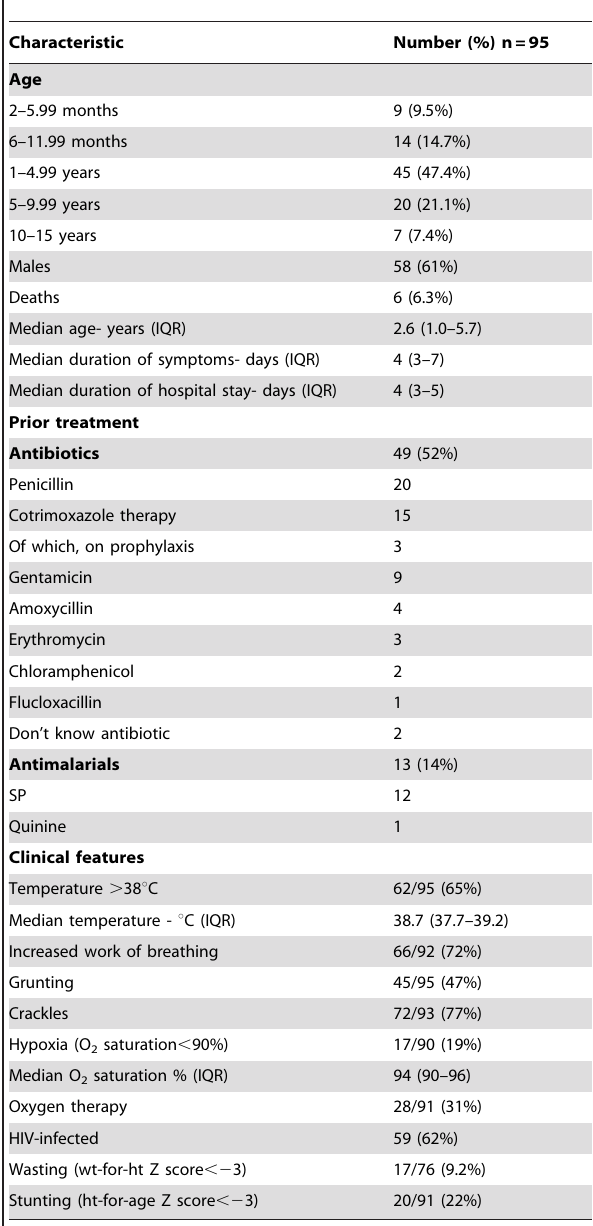
Table 1. Characteristics of children with radiologically confirmed